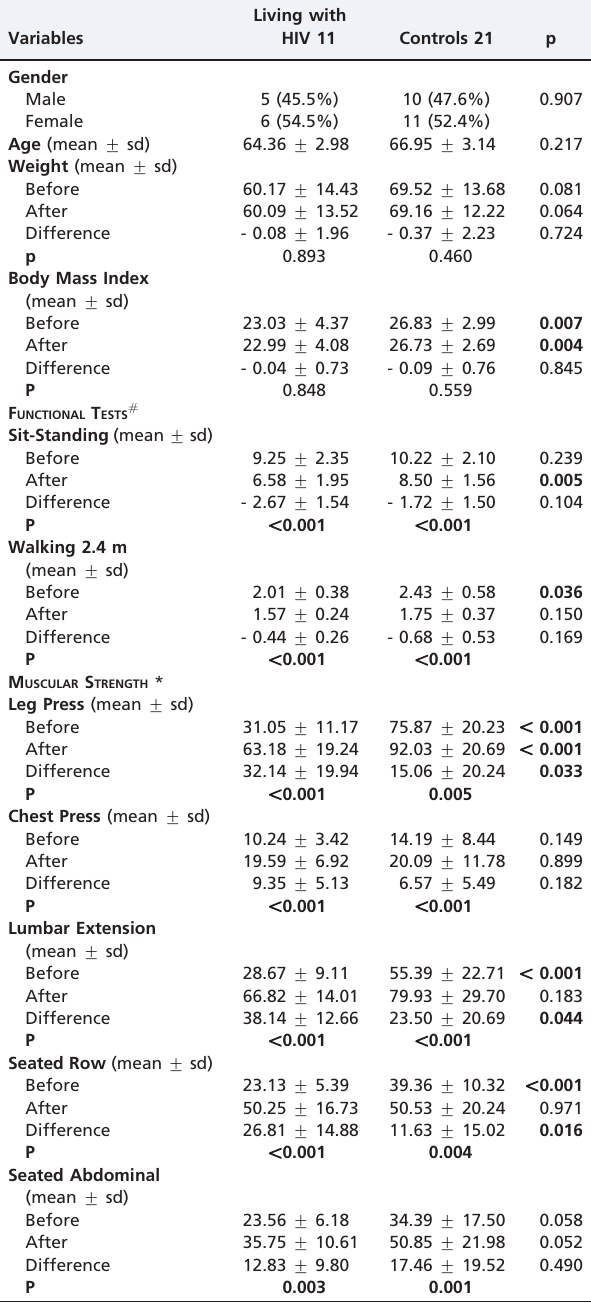
Table 1 - Demographic, anthropometric and functional variables of elderly people living with HIV and Controls, before and after the training